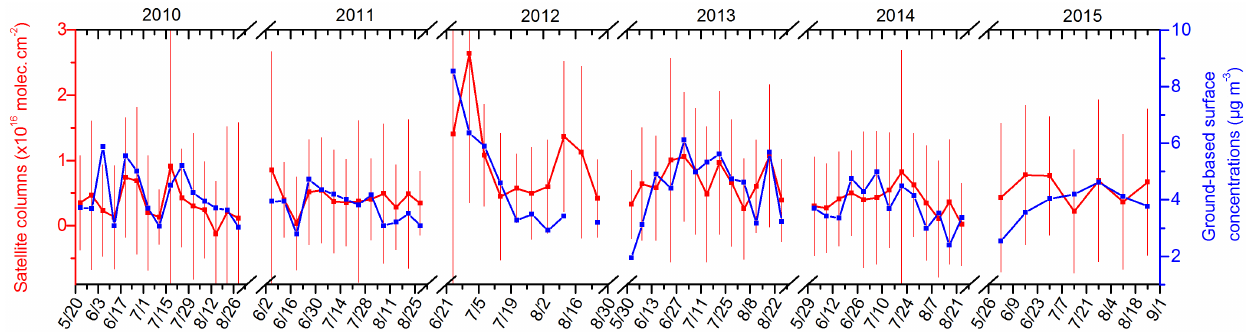
Figure 7. Time series of (bi)weekly averaged IASI-NH 3 satellite column (red, × 10 16 molec.cm − 2 ) and surface concentrations measured by Radiello passive sampler (blue, µgm − 3 ) at FC_W site. The error bars represent the standard deviation of the mean satellite column retrievals.